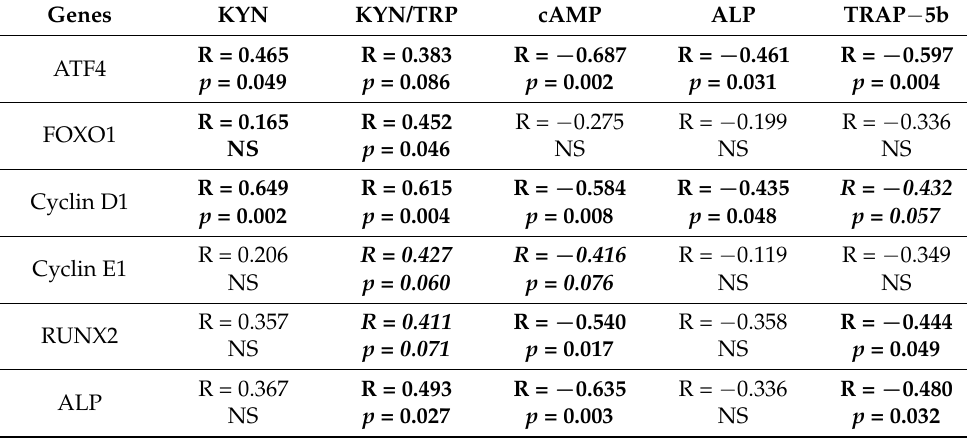
The statistically significant changes are bolded, and tendency to correlation are marked in italics. Abbreviations: NS = non statistically significant; ATF4 = activating transcription factor 4; FOXO1 = Forkhead box transcription factor 1; RUNX2 = Runt-related transcription factor 2; ALP = alkaline phosphatase; TRAP − 5b = tartrate-resistant acid phosphatase 5b; KYN = kynurenine; cAMP = cyclic adenosine monophosphate.